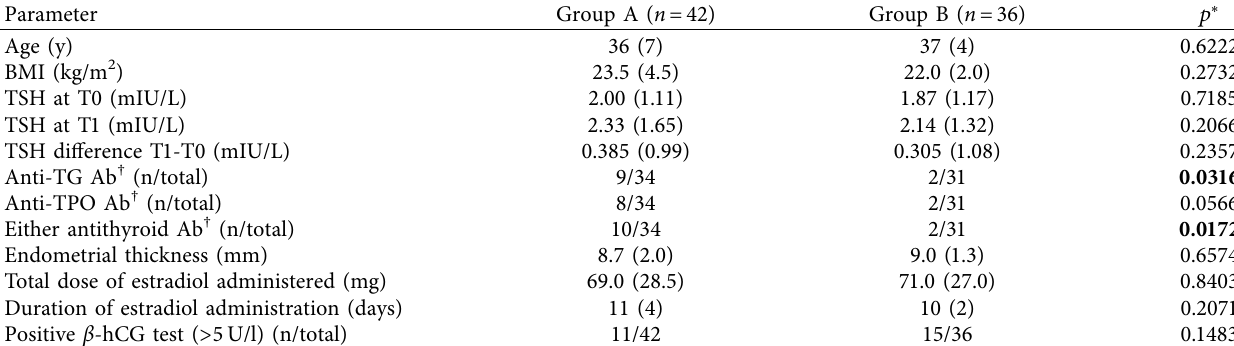
Table 1: Characteristics of the patients, according to groups A and B.